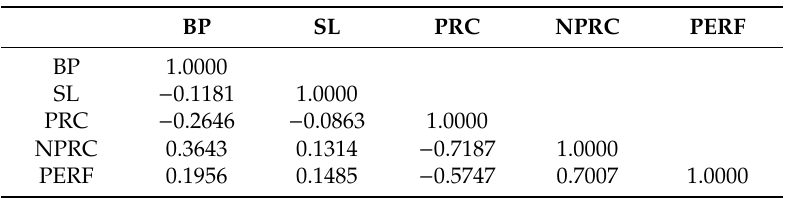
Table 3. Latent variable